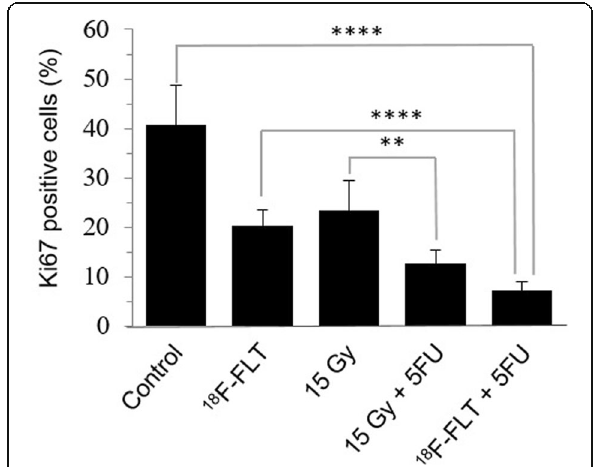
Table 4 Change in body weight of nude mice after